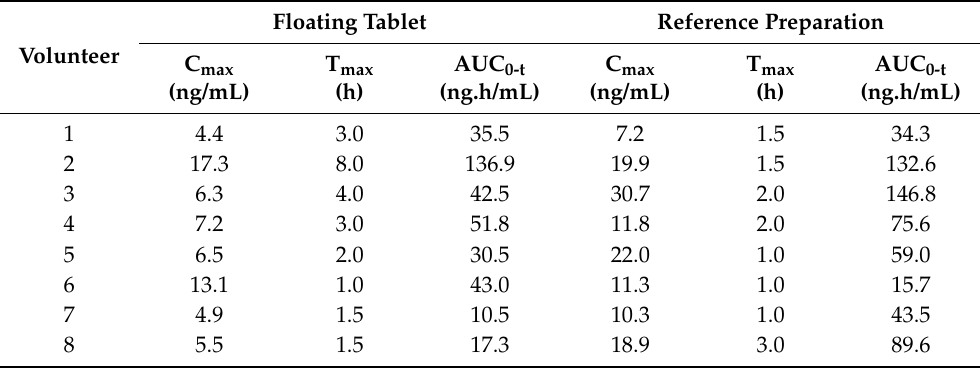
Figure 3. Mean plasma concentration versus time profiles of thiamine after administration of the floating tablet and reference preparation under the fasted condition ( n = 8, mean ± SEM). Table 3. Individual numerical values of C max , T max , and AUC 0-t , and 90% confidence interval for thiamine after administration of floating tablet and reference preparation in the fasted state.